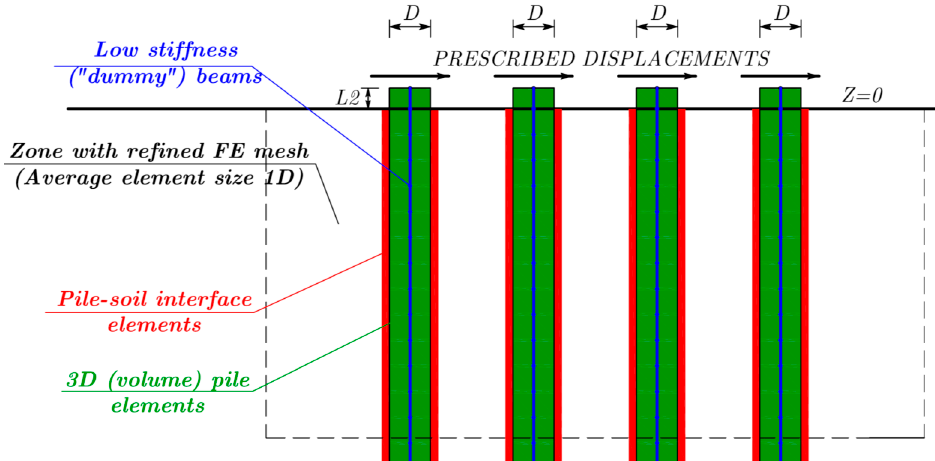
Figure 5. Numerical model components in the mesh refinement zone.